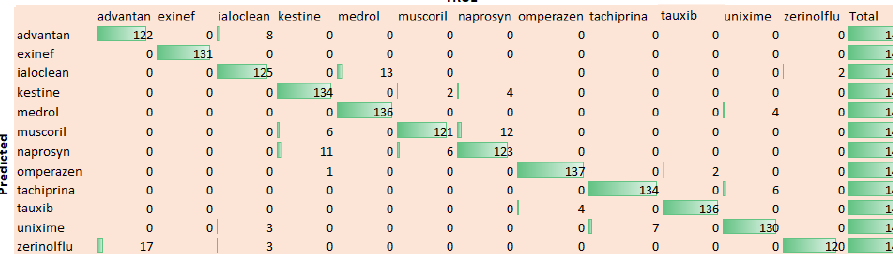
Figure 9. Confusion Matrix for 12 drugs.